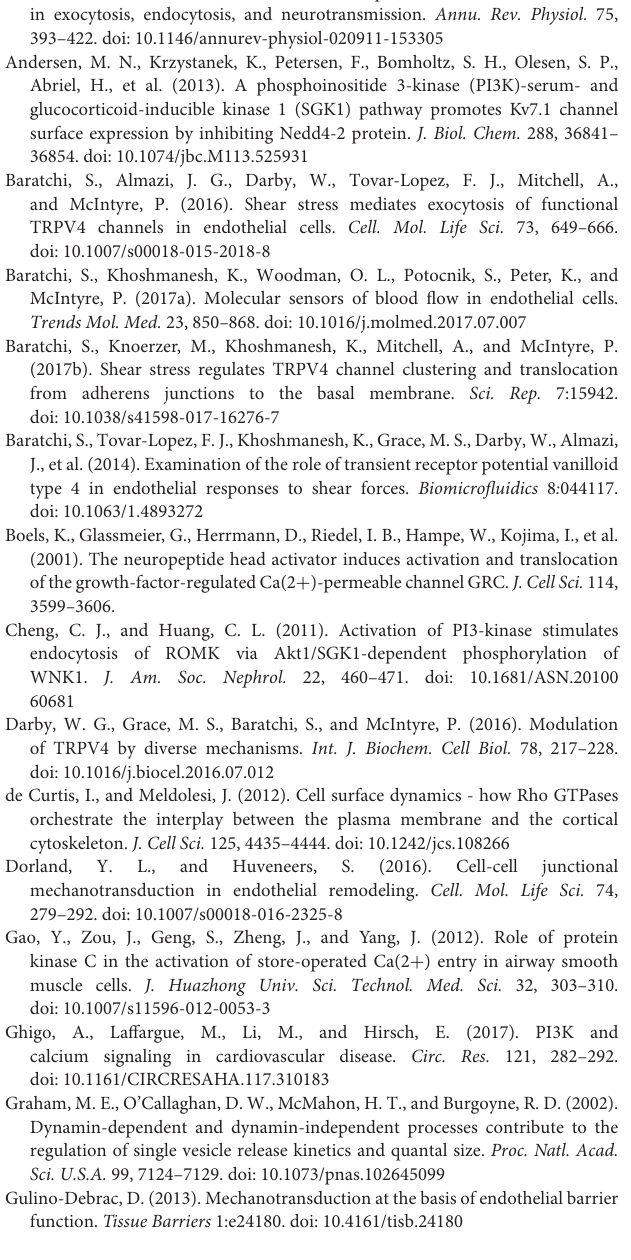
Supplementary Video 5 | TIRF imaging of HEK293-TRPV4-Venus cells treated with dynasore only shows that there is a decrease in the intensity of the TRPV4-Venus fluorescent signal. Supplementary Video 6 | TIRF imaging of HEK293-TRPV4-Venus cells pre-treated with dynasore for 30 min followed by treatment with 100 nM of TRPV4 with